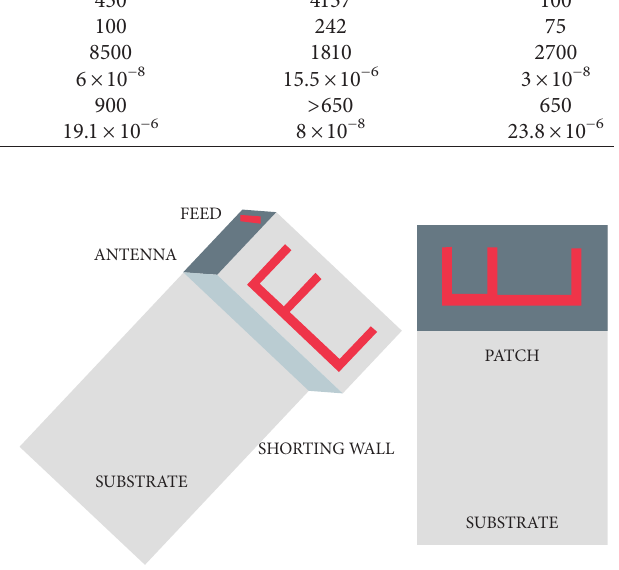
Figure 1: Polymer-based mobile antenna on polycarbonate